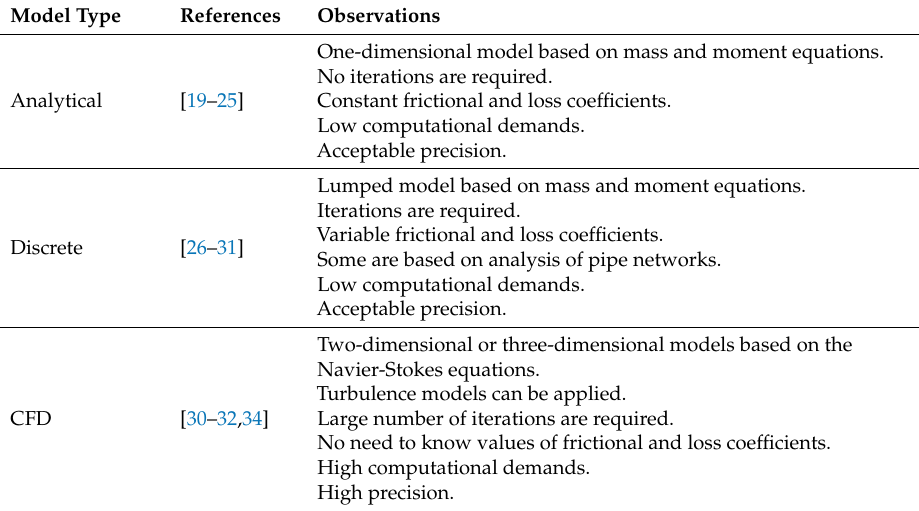
Table 1. Types of models for flow